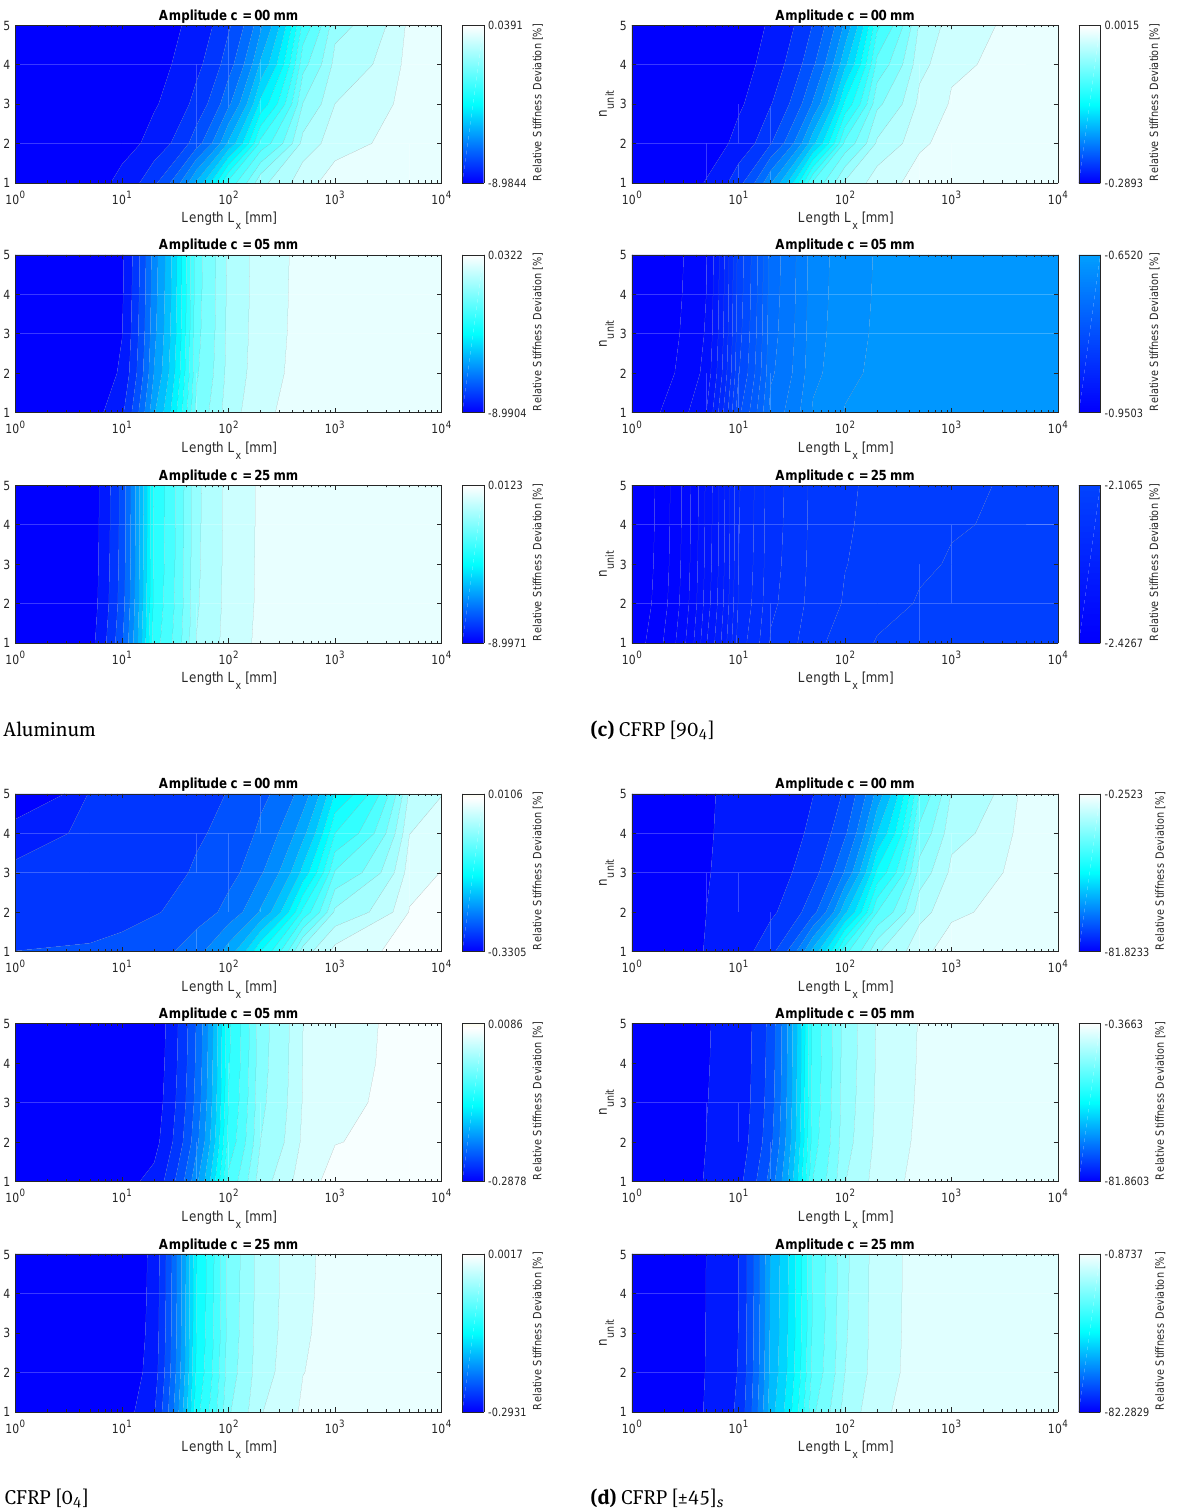
Figure 19: Load case 5 normalized apparent stiffnesses versus L x and n unit - for Aluminum and CFRP [0 4 ]